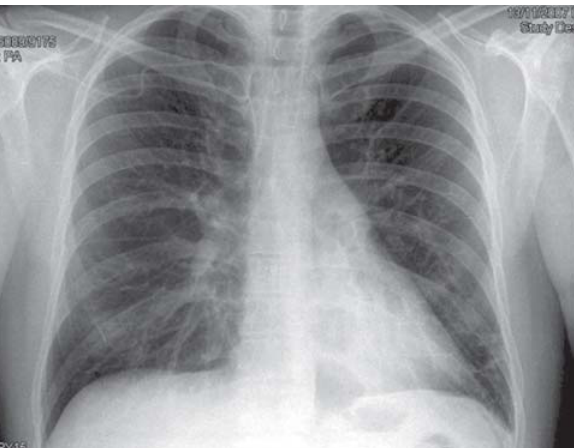
Fig. 5 - A normal pattern of lung field vasculature with a slight enlargement of the cardiac